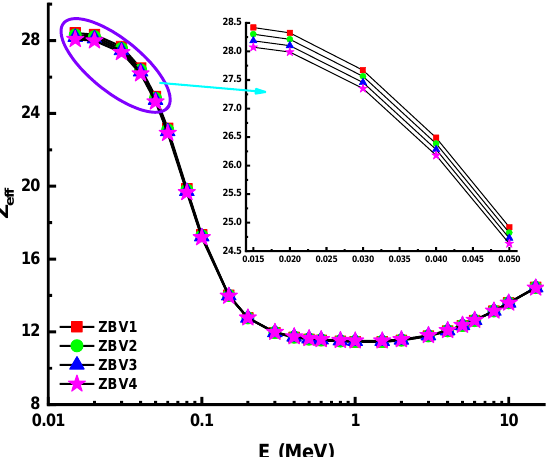
Figure 8. Variation of effective atomic number (Z eff ) against photon energy for all glasses. The Z eff values for ZBV1 glass were the best. For example, a Z eff value of 14.01 was found for the ZBV1 sample at 0.15 MeV. However, the maximum Z eff values recorded for